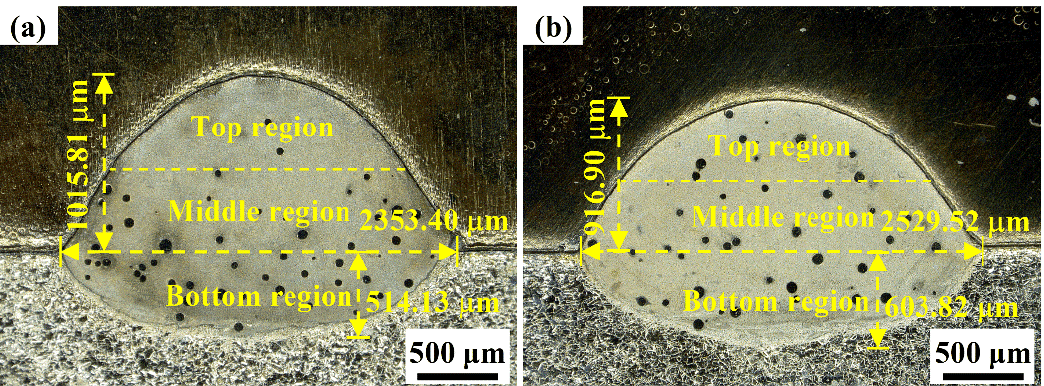
Figure 3. The typical cross-sectional morphologies of coatings ( a ) without ultrasonic vibration and ( b ) with ultrasonic vibration.